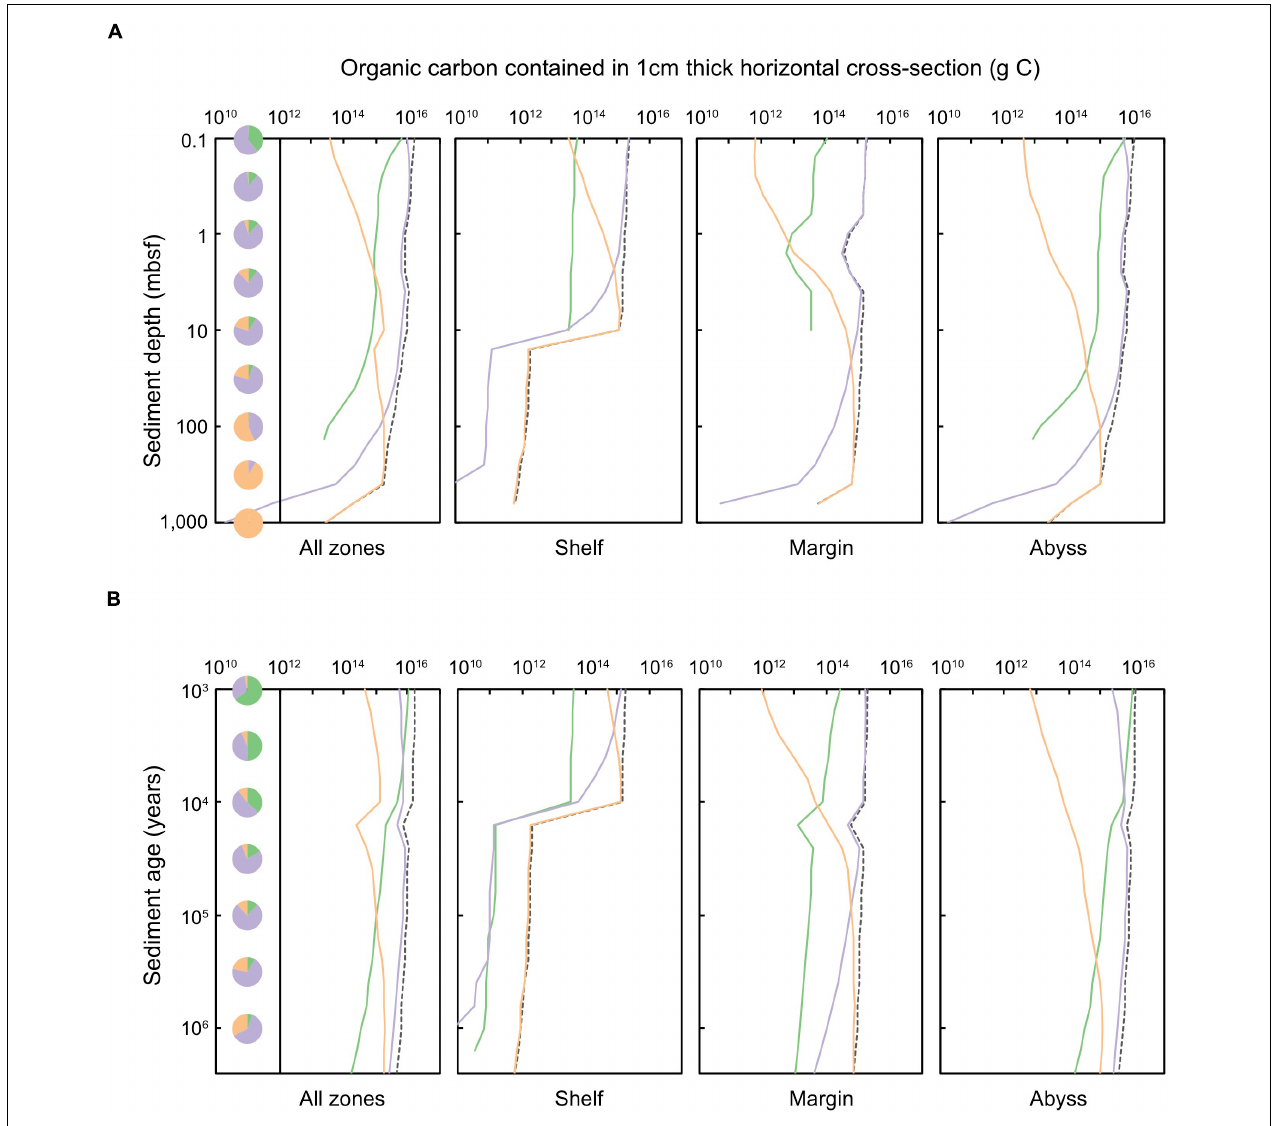
FIGURE 4 | Total organic carbon stored in a 1 cm thick layer of global marine sediments deposited up to 2.59 million years ago, according to equal (A) sediment depth (shown for sediments at 0.1 to ∼ 10,000 mbsf) and (B) sediment age (1,000 years to 2.59 million years). The dashed black line represents the total organic carbon contained in specific depth or age layers. Shading of solid lines indicates the organic carbon contained in sediments of a specific catabolic zone: green shading represents oxic sediments, lilac denotes sulfate-reducing sediments, and orange signifies methanogenic sediments. Pie charts indicate the proportion of total POC that is stored within all oxic, sulfate-reducing, and methanogenic sediments of a specific (A) depth or (B) age